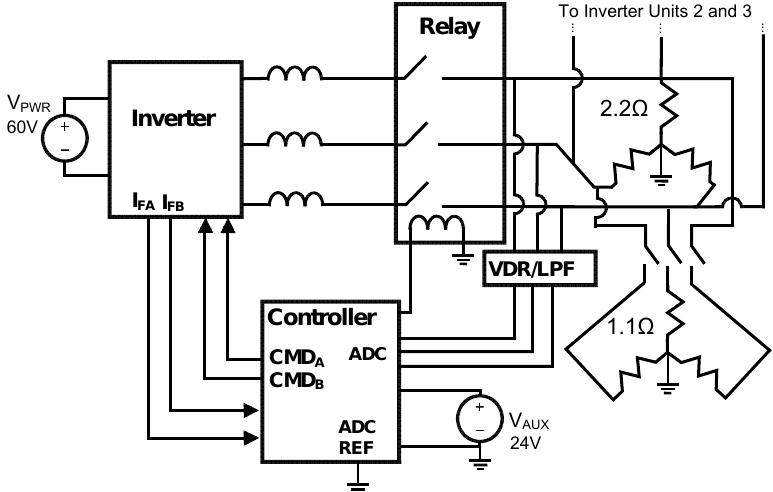
Figure 6. One inverter subunit coupled to a Y-connected load. The inverter’s control signal reference and its negative DC rail are isolated. The negative DC power rail of each inverter floats in isolation. Each subunit’s controller reads V g , A and V g , B , the load voltages on phases A and B, and receives feedback of the amplifier output current. Additional inverter subunits are connected in parallel to the load for synchronization testing. The inverter can be either voltage-sourced and receive a voltage command, or current-controlled with a current command